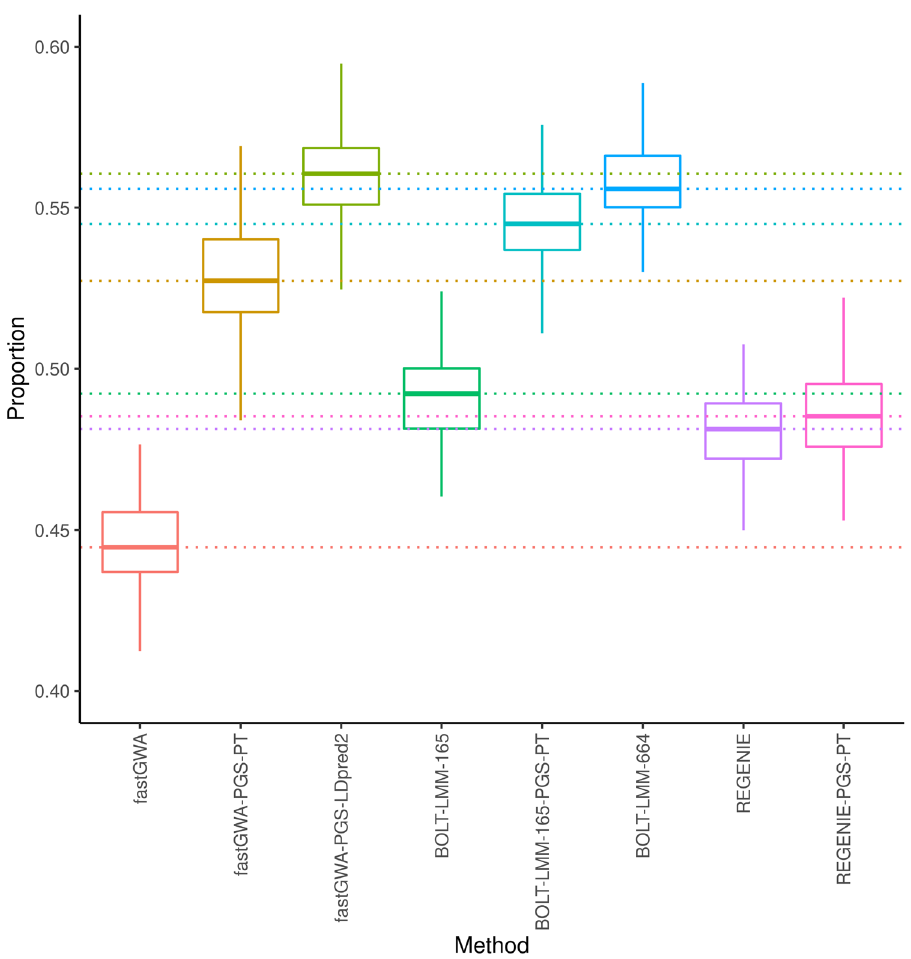
Figure 1. The proportion of causal variants recovered in 100 simulations. The boxplot shows the median (center line), upper and lower quartiles (hinges) and the maximum and minimum values not more than 1.5 times the interquartile range from the corresponding hinge (whiskers). The simulations consisted of 100,000 individuals and a continuous trait, with narrow-sense heritability of 0.5 and 1000 causal variants. BOLT- LMM-165 denotes BOLT-LMM with a GRM derived from 165,684 variants resulting from strict LD-pruning. BOLT-LMM-664 refers to the use of BOLT-LMM with a GRM derived from all 664,393 variants in the simulations. Methods that include PGS in the name involved the use of a LOCO PGS fixed effect, derived either from pruning and thresholding (methods ending in PT) or using